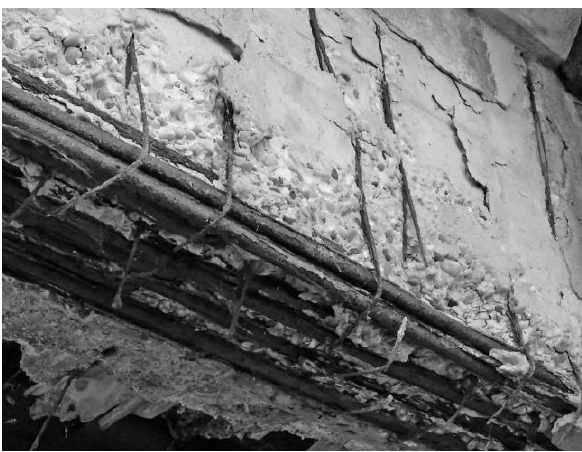
Figure 6. Beams deterioration on the side